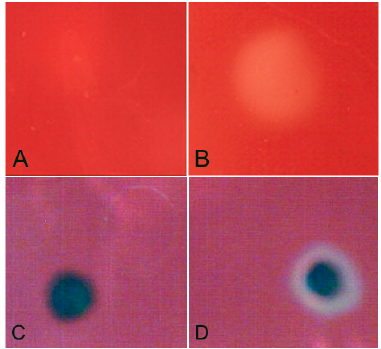
Figure 3. Cellulase activity of X. index homogenate ( B ) and the recombinant X. index GH12 ( D ). Negative controls are shown in panels ( A ) (buffer alone) and C (bacteria lacking cloned GH12 sequence).